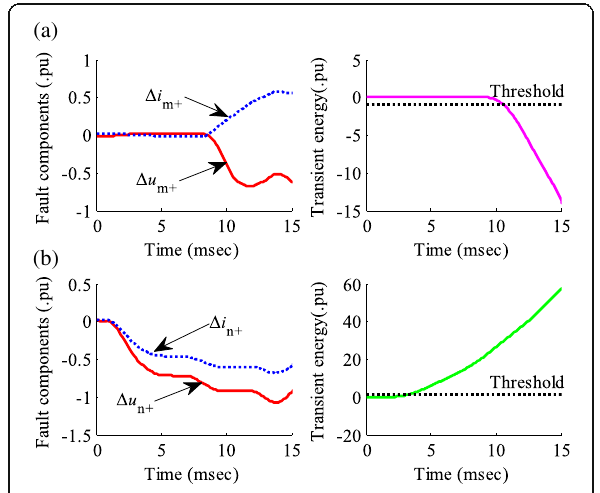
Fig. 13 Waveforms of fault components and transient energies detected on the positive pole line for a fault at F 5. a Rectifier station. b Inverter station